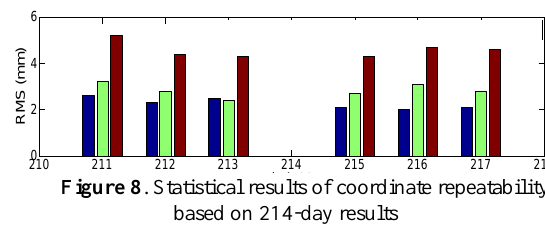
Figure 8 . Statistical results of coordinate repeatability based on 214-day results The average values of coordinate RMS in N, E and U directions are 2.3mm, 2.8mm and 4.6mm